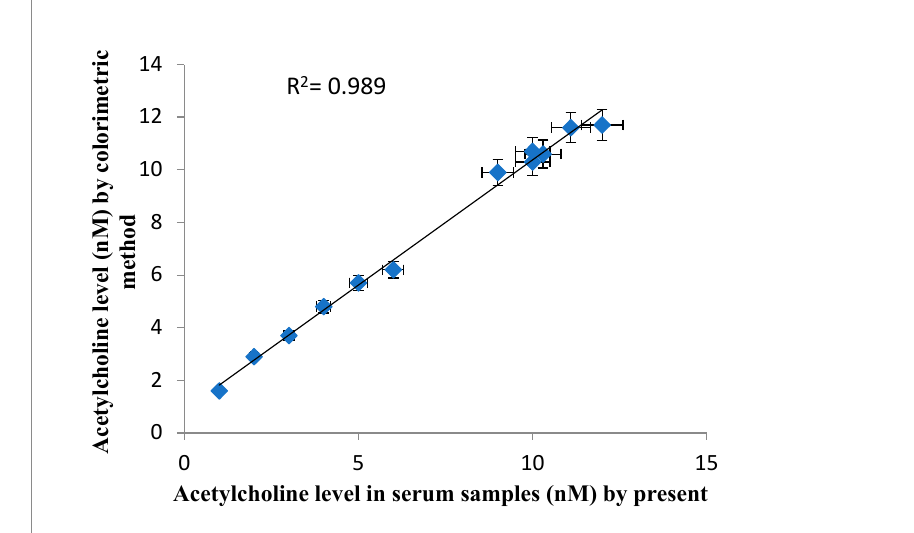
Figure 9. Correlation between serum acetylcholine level measured by standard method ( y -axis) and the present method ( x -axis) using the present acetylcholine biosensor based on AChENPs/ChONPs/GONS/PtNPs/PGE. (AChENPs = Acetylcholine esterase nanoparticles; ChONPs = Choline oxide nanoparticles; GONS = Graphene nanosheets; PtNPs = Platinum nanopar- ticles; PGE= Pencil graphite electrode). The line represents the correlation of acetylcholine level mea- sused in same serum sample by the standard colorimetric method (y axis) and present biosensing method (x-axis). The points shows the acetylcholine level in the same serum sample by the standard method and the present method with standard deviation.